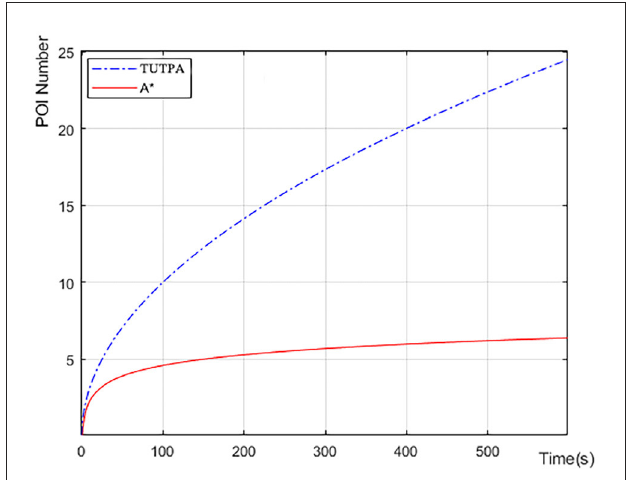
FIGURE12 Average number of POI visits for multiple experiments.